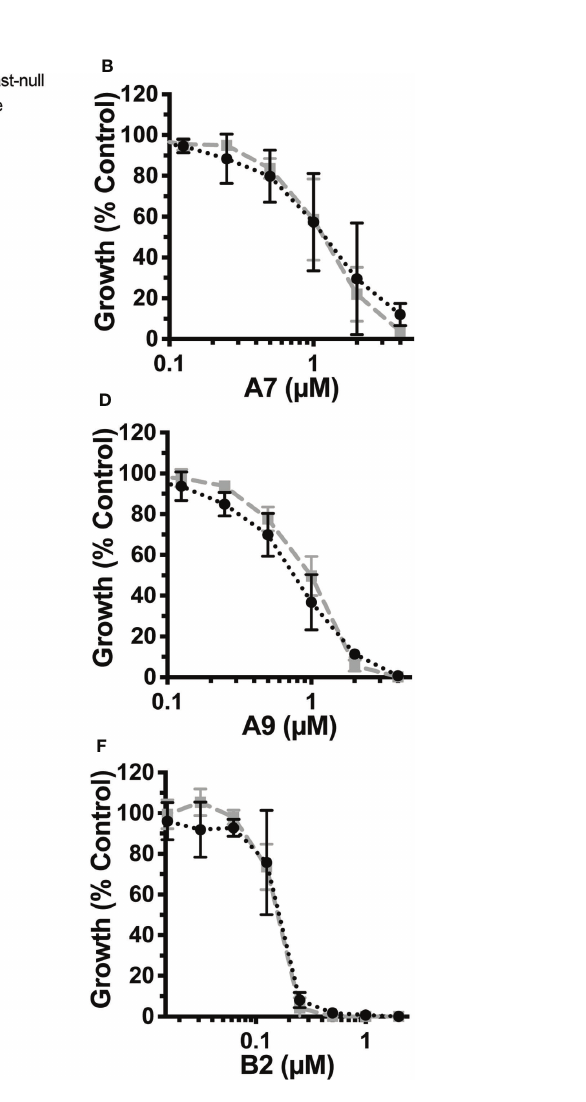
FIGURE 4 Removal of the apicoplast does not rescue parasites from azithromycin analogue activity. Early ring-stage P. falciparum D10-PfPHG wildtype and D10-PfPHG apicoplast-null parasites (<4 hrs post-invasion) were treated with doubling dilutions of analogues and inhibition of growth measured 2 cycles latter (delayed death, 120 hrs) for compounds: (A) A5 (D10-PfPHG apicoplast-null IC 50 , 0.5 m M; D10-PfPHG wildtype IC 50 , 0.4 m M. P=NS). (B) A7 (D10-PfPHG apicoplast-null IC 50 , 0.37 m M; D10-PfPHG wildtype IC 50 , 0.49 m M. P=NS). (C) A8 (D10-PfPHG apicoplast-null IC 50 , 0.63 m M; D10-PfPHG wildtype IC 50 , 0.62 m M. P=NS). (D) A9 (D10-PfPHG apicoplast-null IC 50 , 1.4 m M; D10-PfPHG wildtype IC 50 , 1.8 m M. P=NS). (E) A11 (D10-PfPHG apicoplast-null IC 50 , 1.6 m M; D10-PfPHG wildtype IC 50 , 2.9 m M. P=NS). (F) B2 (D10-PfPHG apicoplast-null IC 50 , 0.17 m M; D10-PfPHG wildtype IC 50 , 0.16 m M. P=NS). Data represents the means of 2 (or more) experiments expressed as percentage of non-inhibitory control and error bars represent the